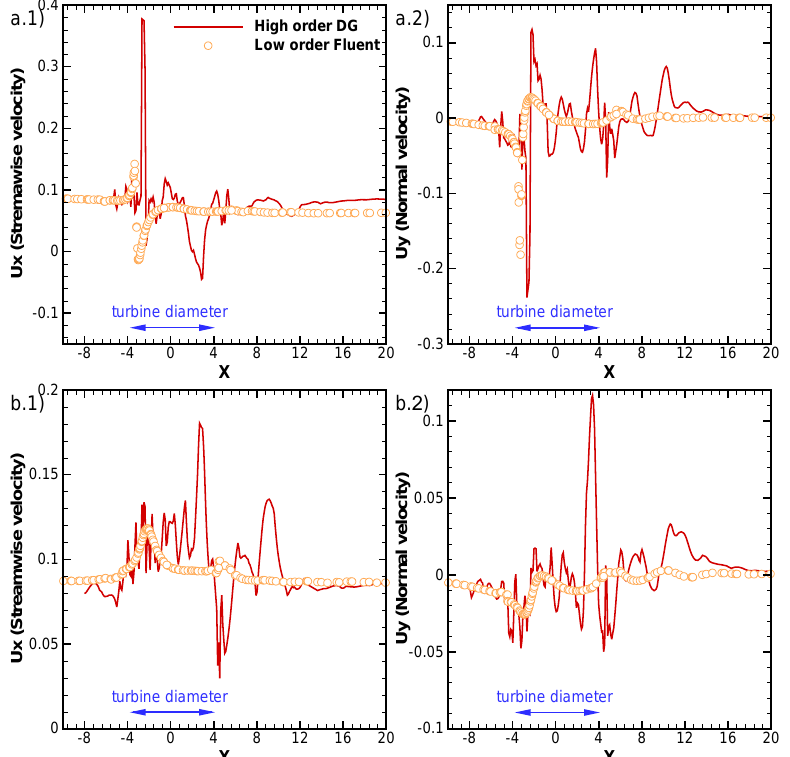
Figure 3. Simulations of vertical axis turbine: Flow velocity components at lines: ( a.1 ) streamwise velocity u x at y = − 2 m, ( a.2 )normal velocity u y at y = − 2 m; ( b.1 ) streamwise velocity u x at y = − 4 m, ( b.2 ) normal velocity u y at y = − 4 m. We include results from the 3D high order DG simulation (LES turbulence model) and from the low order fluent simulation k-omega SST turbulence